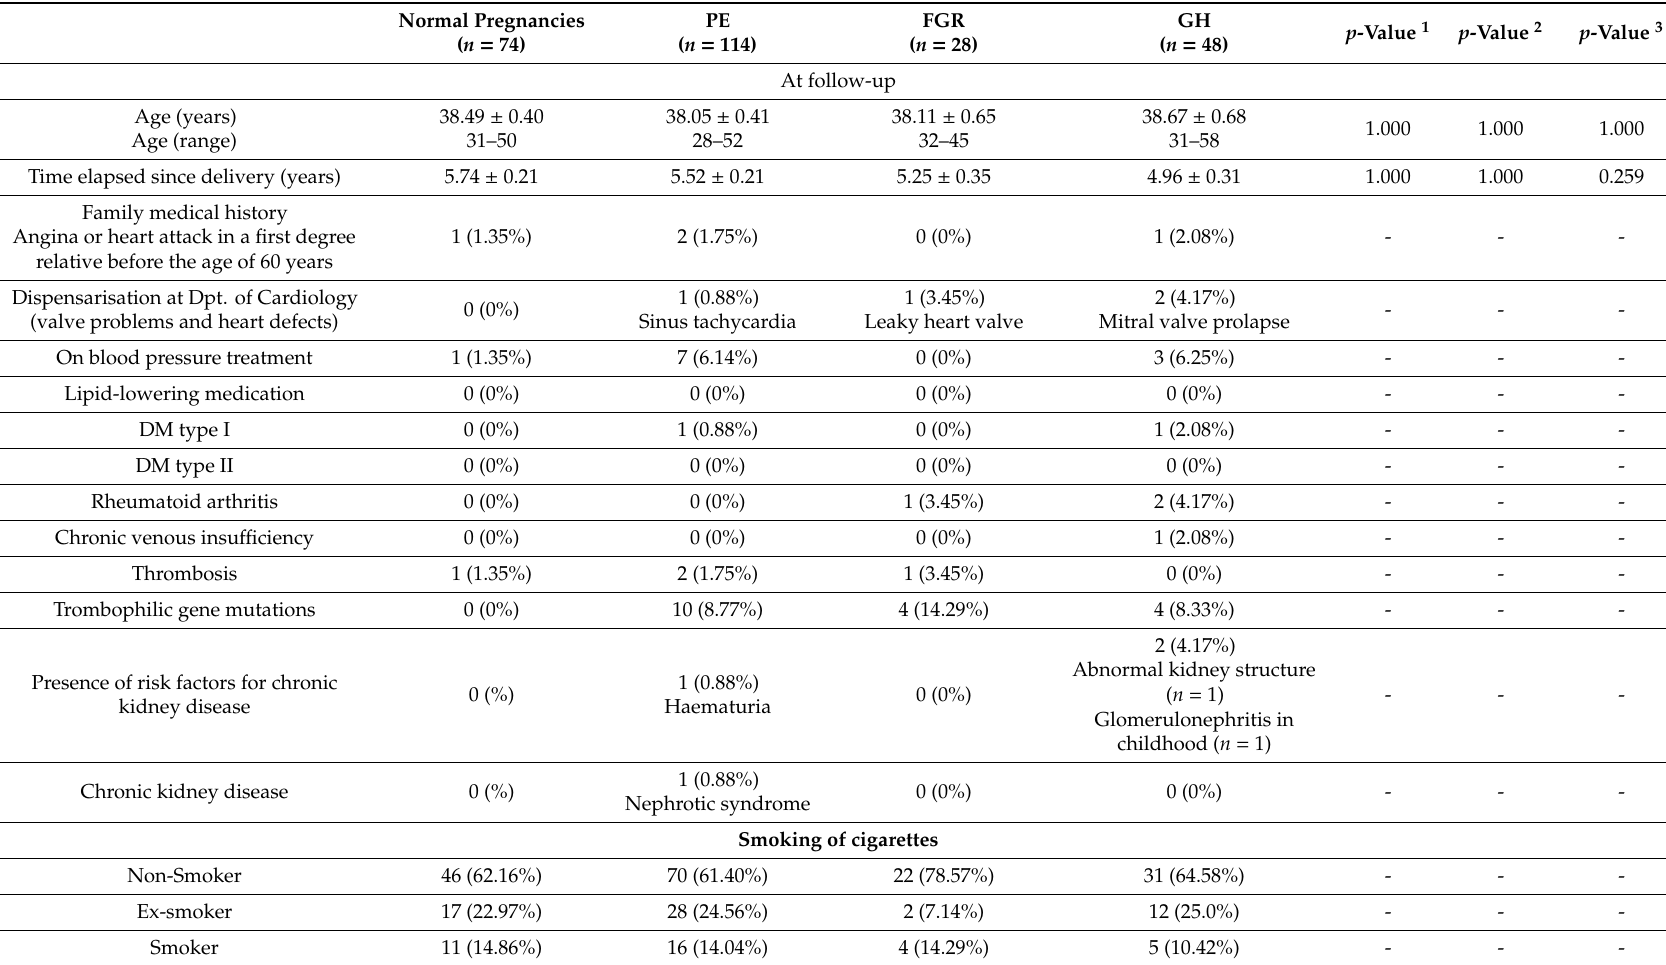
Table 8. Characteristics of women involved in the study with respect to a history of pregnancy, pregnancy-related complications and classical cardiovascular risk